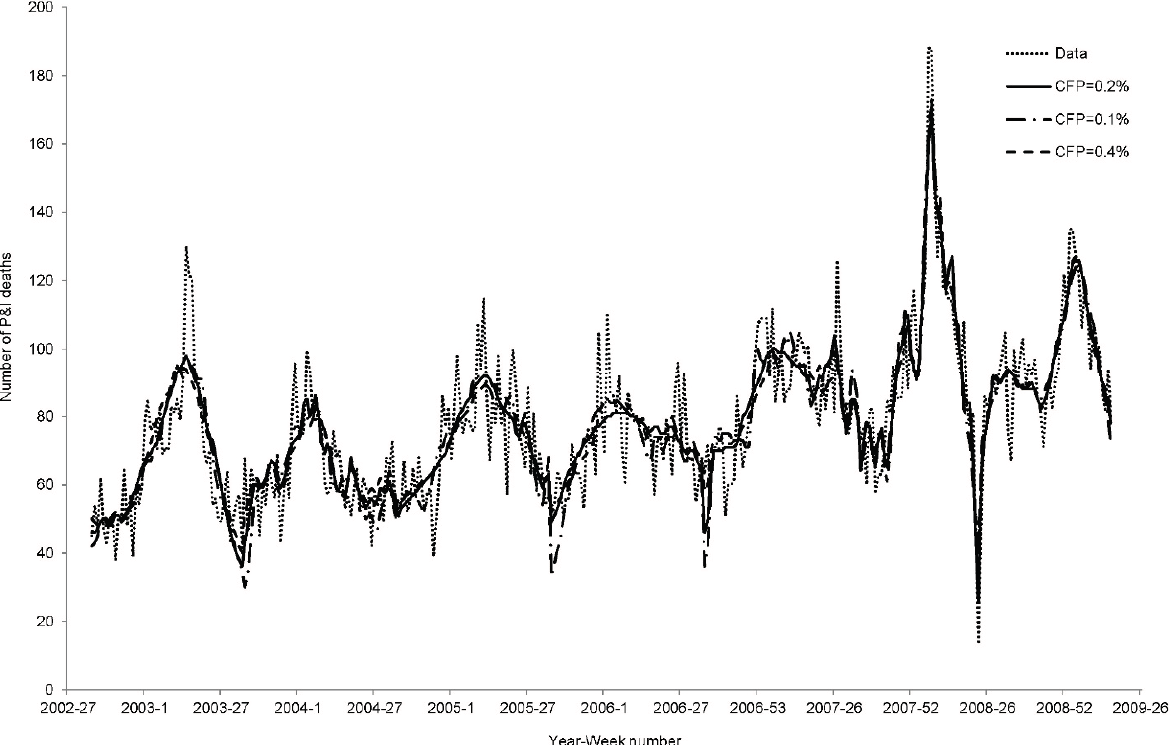
Figure 4. Best fitted curves for CFP = 0.2%, 0.1%, and